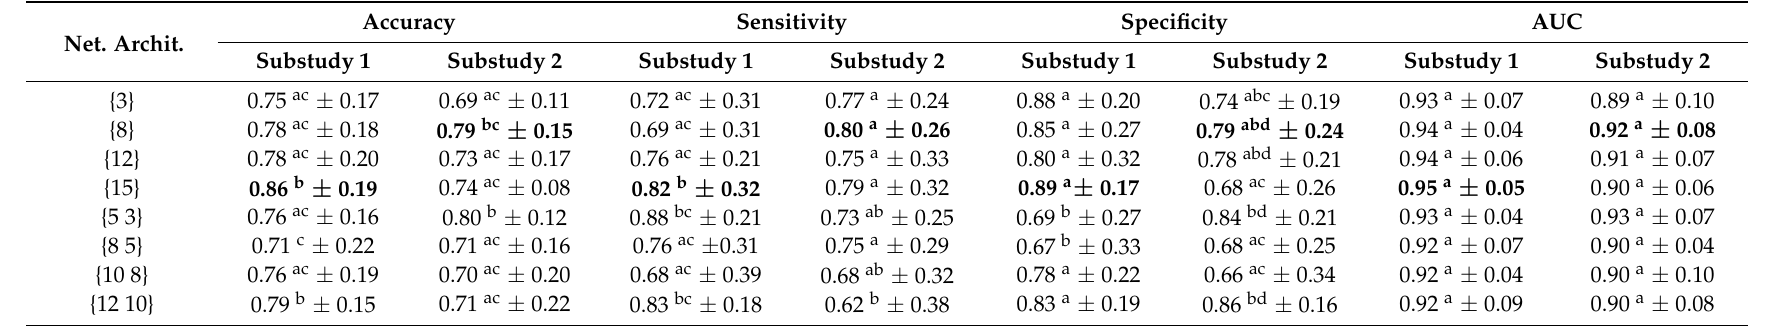
Table 3. Results of the evaluated architectures for the multi-layer perceptron neural network (MLPNN) analysis with the test data. Data are presented in the following form: mean ± standard deviation. Means in a column with no common superscript letter differ significantly according to Tukey’s honest significance test for a value of p < 0.01. Substudy 1 has 17 neurons in the input layer (all the neuropsychological tests) and substudy 2 has eight neurons in the input layer (test with more significant differences from Table 2: the Digit Span Backward, the copy of the Rey complex figure and the six subsets of the TAVEC test). The best results for each substudy are in bold. Net. Archit. = Network